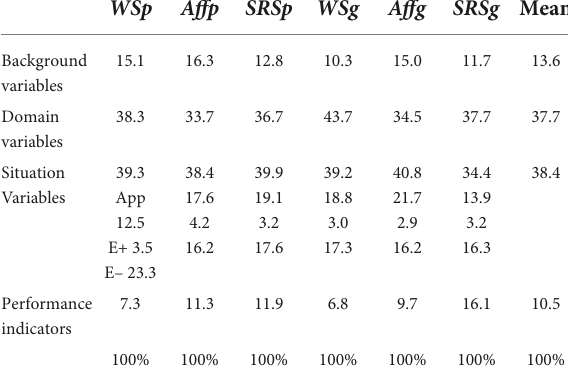
TABLE 8 Comparative predictive weight contribution for the six attributions by each of the categories of predictor